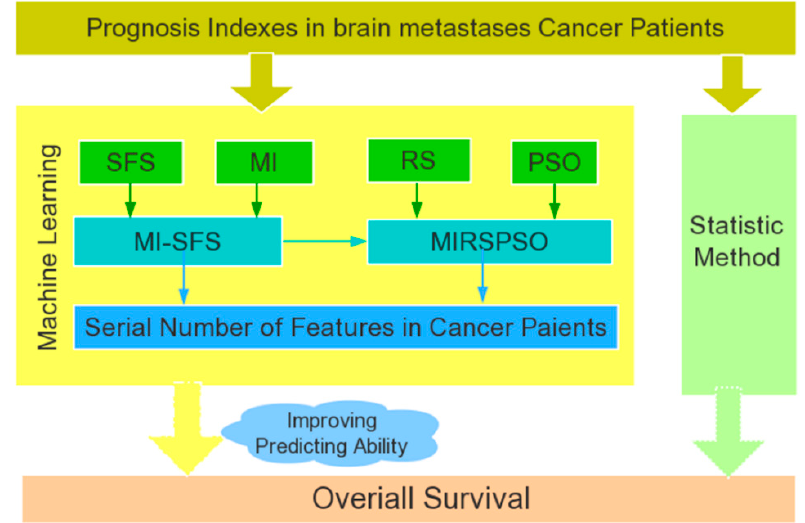
Figure 6. The relationship among the methods used in this study.